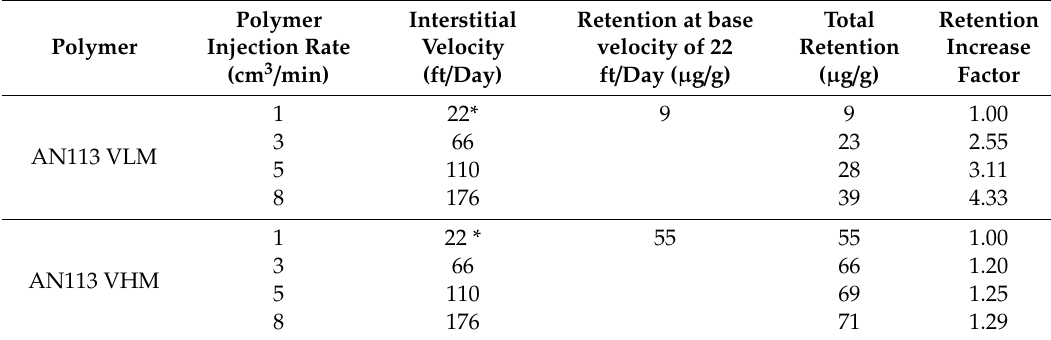
Figure 4. Polymer breakout curves at various rates for ( a ) AN 113 VLM and ( b ) AN 113 VHM. *The “Second 22 ft/day” breakout curve represents no adsorption case, hence is usable as the reference slug to determine the area between the curves for all runs of different flow rates. Table 4. Hydrodynamic Retention for AN 113 VLM and AN 113